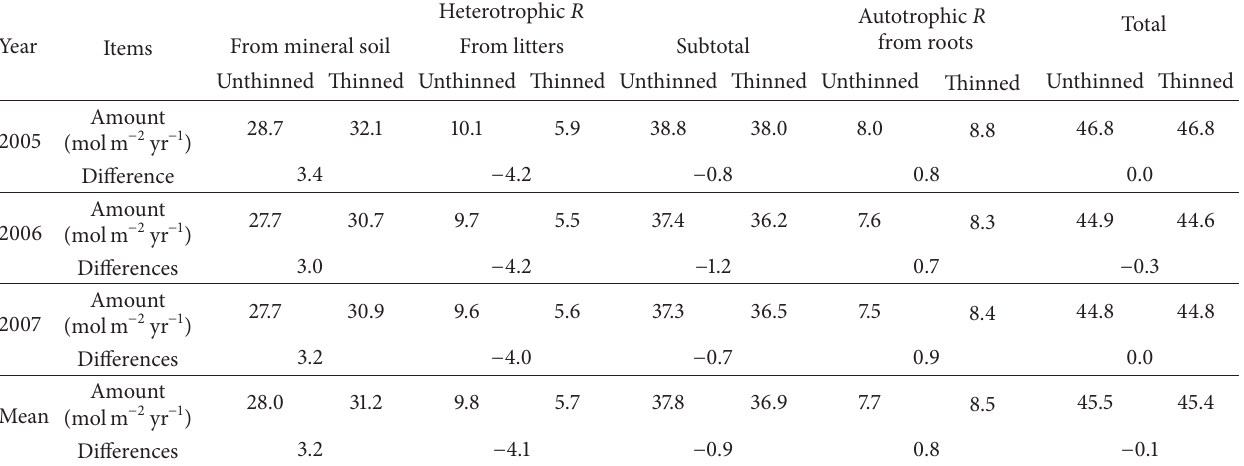
Table 2: Annual effluxes from different components of soil respiration at the thinned and unthinned sites. Heterotrophic